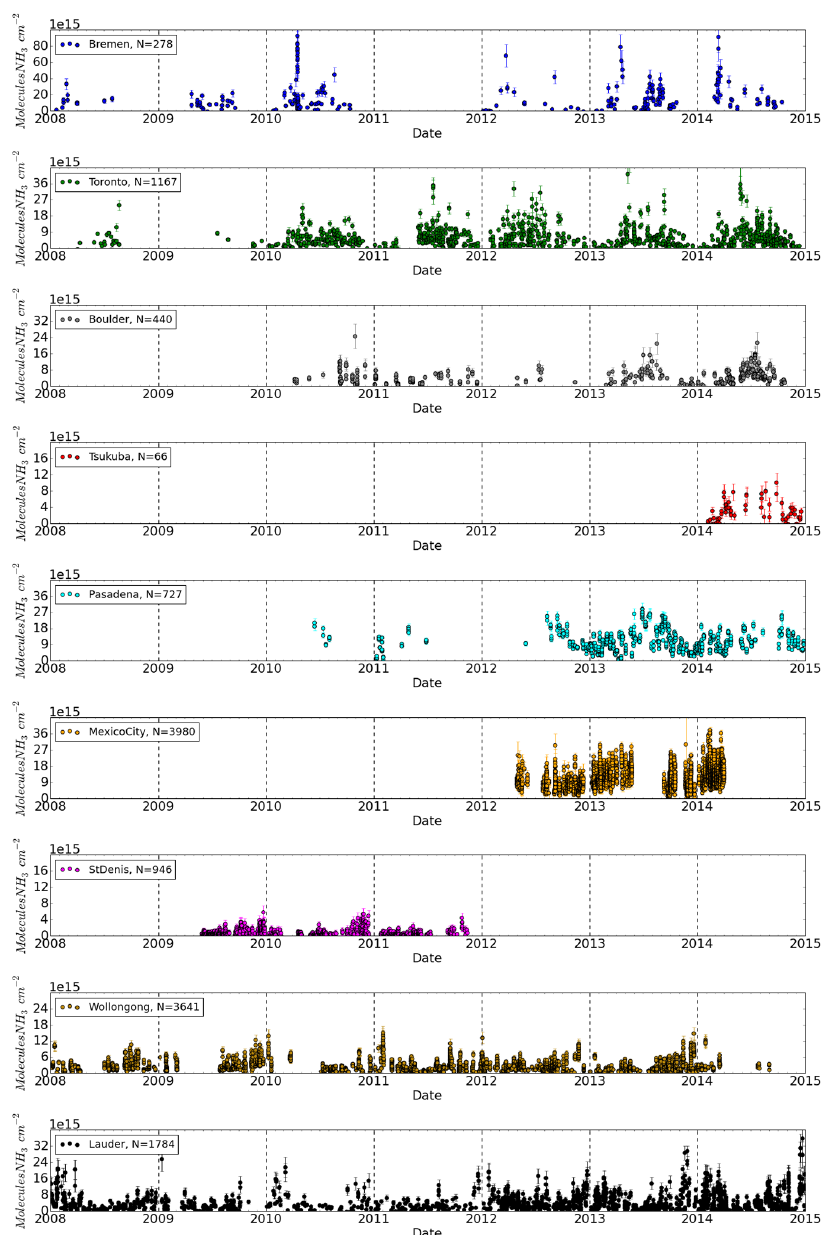
Figure 2. FTIR-retrieved NH 3 total columns (in moleculescm − 2 ) . Note that the labels on the vertical axis vary for each site.